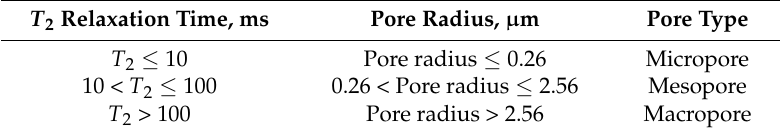
Figure 3. Pore radius distribution. Table 3. Relationship between T 2 , pore radius, and pore type.